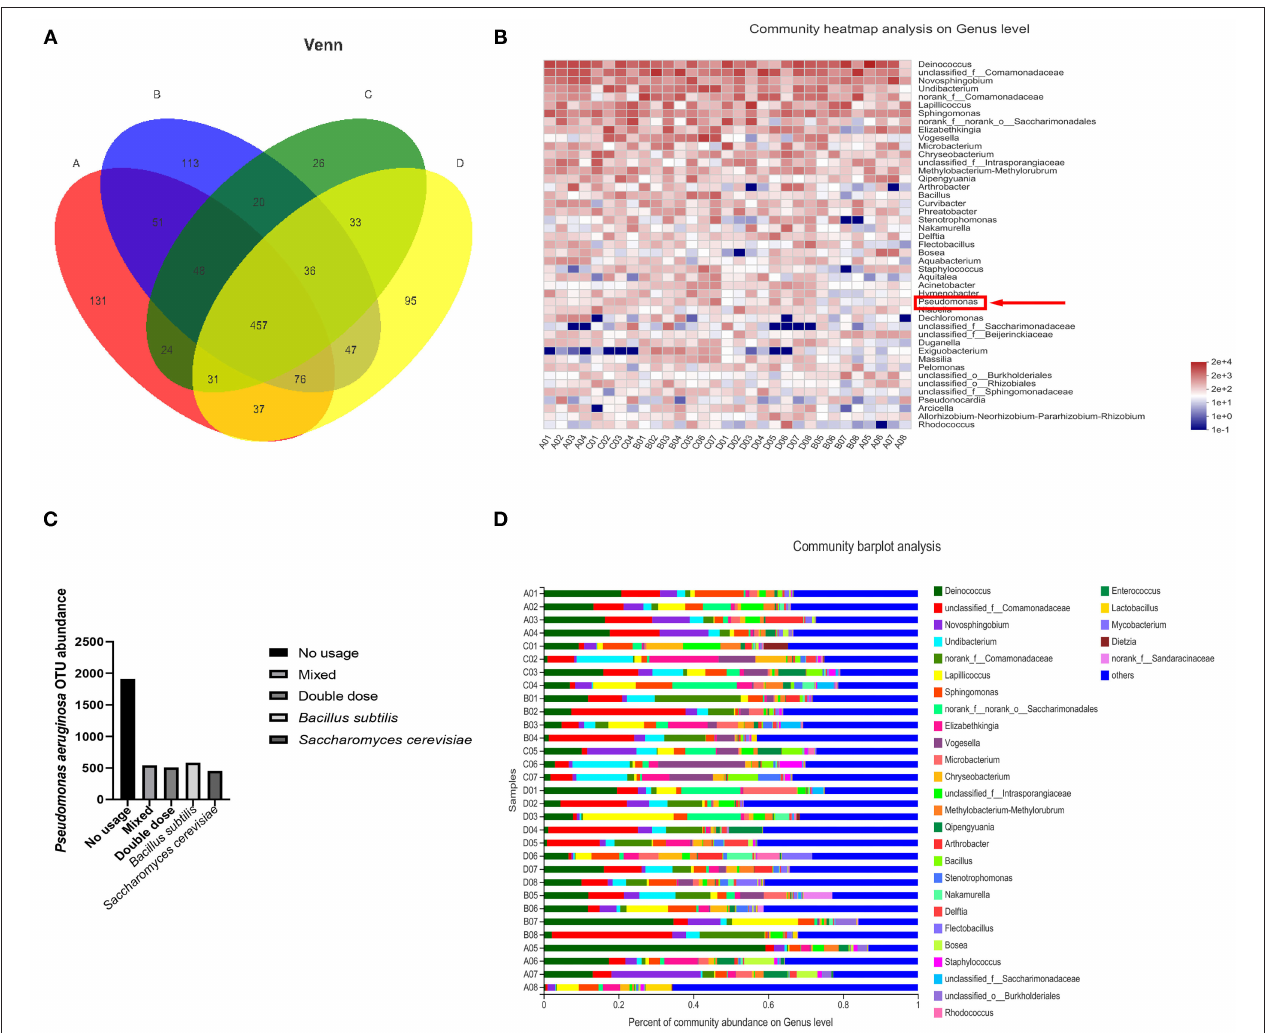
FIGURE 3 | (A) Venn diagram of relationship between four experimental groups at genus level from sequencing statistics, with focus on commonality in these groups. (B) Heatmap of microbiota in experimental individuals. Pseudomonas (red arrow) is lower in that in control. (C) Differences in OTU abundance between experiment and control groups. (D) Composition of microbiota in experimental groups. Level of four kinds of pathogen is quite lower than samples from control group (in former research)